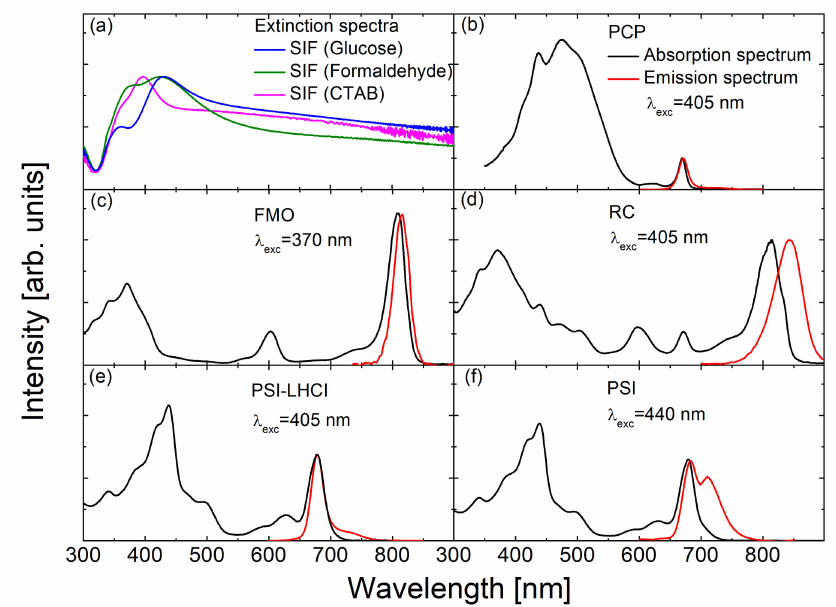
Figure 2. Optical characterization of the SIF substrates ( a ) and the pigment–protein complexes: peridinin-chlorophyll-protein (PCP) ( b ), Fenna–Matthews–Olson (FMO) ( c ), reaction centers (RC) ( d ), Photosystem I with attached antenna clusters (PSI-LHCI) supercomplex ( e ), and Photosystem I (PSI) complex ( f ). Absorption spectra are marked in black; emission spectra are shown in red. Excitation wavelengths are also given in each